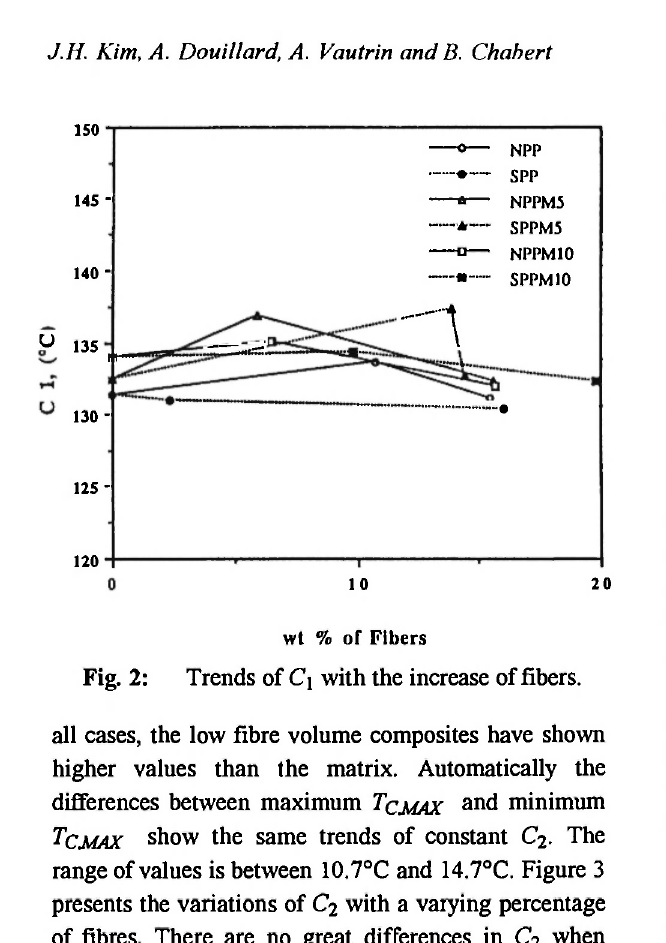
Fig. 2: Trends of C\ with the increase of fibers. all cases, the low fibre volume composites have shown higher values than the matrix. Automatically the differences between maximum TQMAX an d minimum TCMAX show the same trends of constant C 2 . The range of values is between 10.7°C and 14.7°C. Figure 3 presents the variations of C 2 with a varying percentage of fibres. There are no great differences in C 2 when increasing the quantity of fibres. It is likely that the constant C\ and the trends of C 2 have been affected by the matrix.